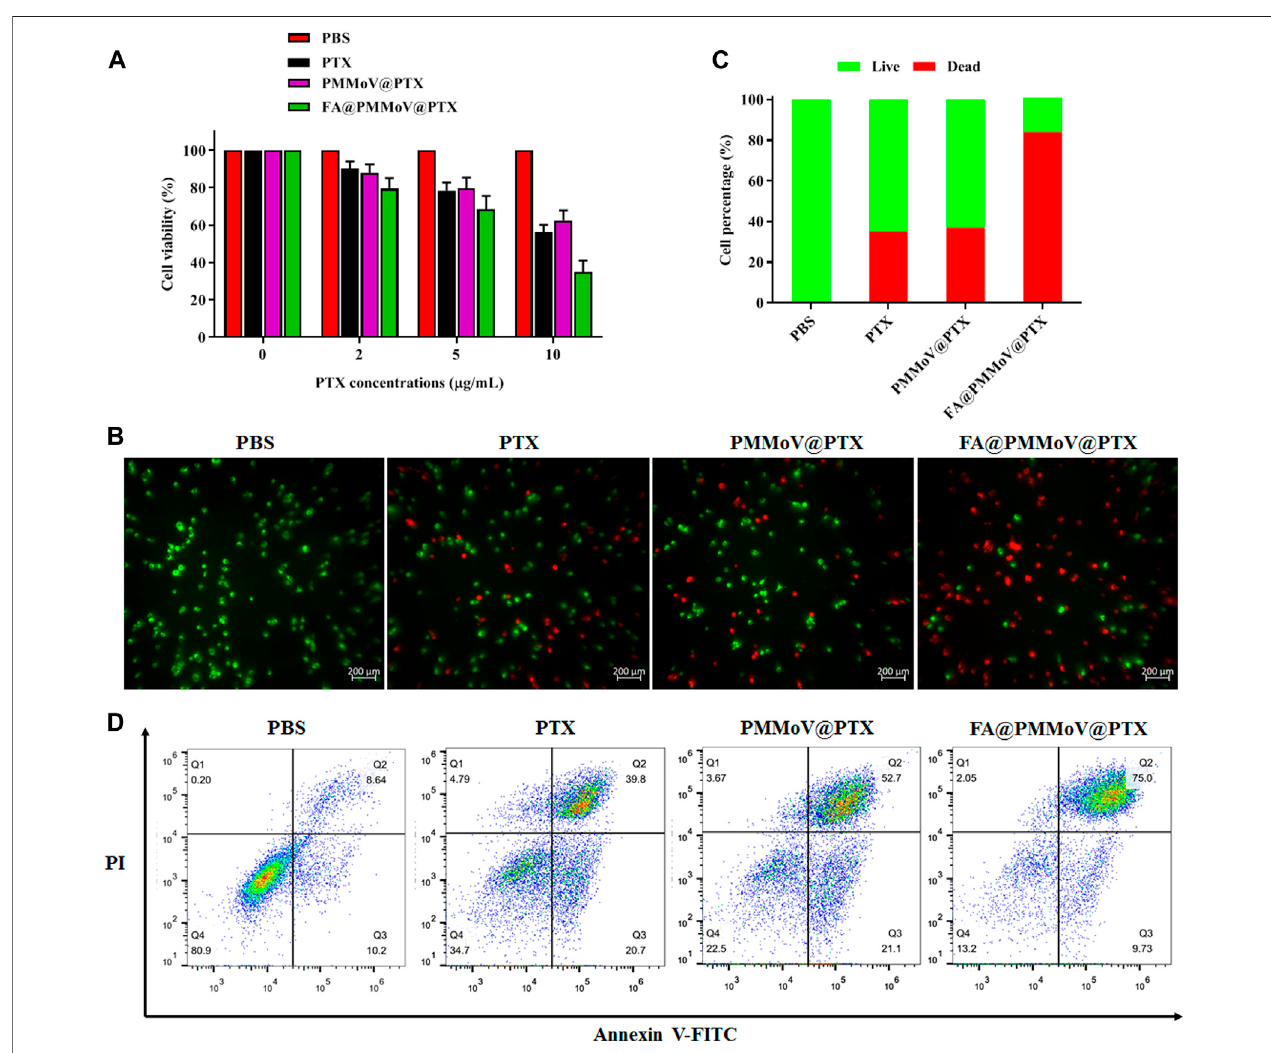
FIGURE 4 | The in vitro anti-tumor activity of FA@PMMoV@Dir nanotubes. (A) Cell viability of MCF-7 treated with different concentrations of FA@PMMoV@Dir nanotubes. (B) Images showing the fl uorescence of MCF-7 cells co-stained with calcein-AM and Ethd-1 and treated with FA@PMMoV@Dir nanotubes. (C) The semi- quantitative values of fl uorescence signals from (B). (D) Flow-cytometry-based apoptosis assay for MCF-7 cells treated with FA@PMMoV@Dir nanotubes.